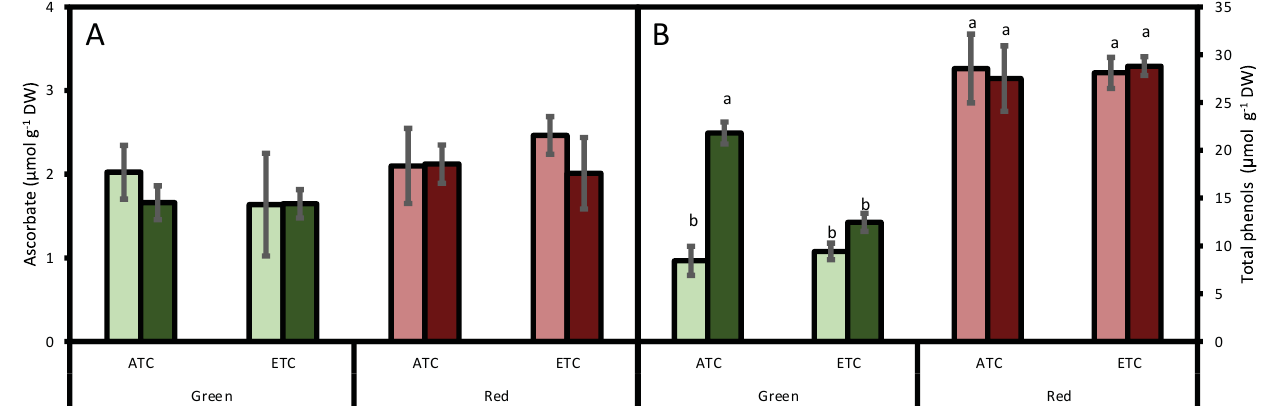
Figure 3. Effect of A. alternata inoculum and environmental conditions on ascorbate ( A ) and total phenols ( B ) of two differently-colored fresh lettuces. Light green bars represent green fresh lettuces grown without inoculum (Aa − ), dark green bars represent green fresh lettuces grown with inoculum (Aa+), light red bars represent red fresh lettuces grown without inoculum (Aa − ), and dark red bars represent red fresh lettuces grown with inoculum (Aa+). (ATC) refers to lettuces grown under the present climatic scenario and (ETC) to those grown under a climate change scenario. Each value represents mean ± standard error (n = 4). Significant differences ( p < 0.05) are indicated by different letters.